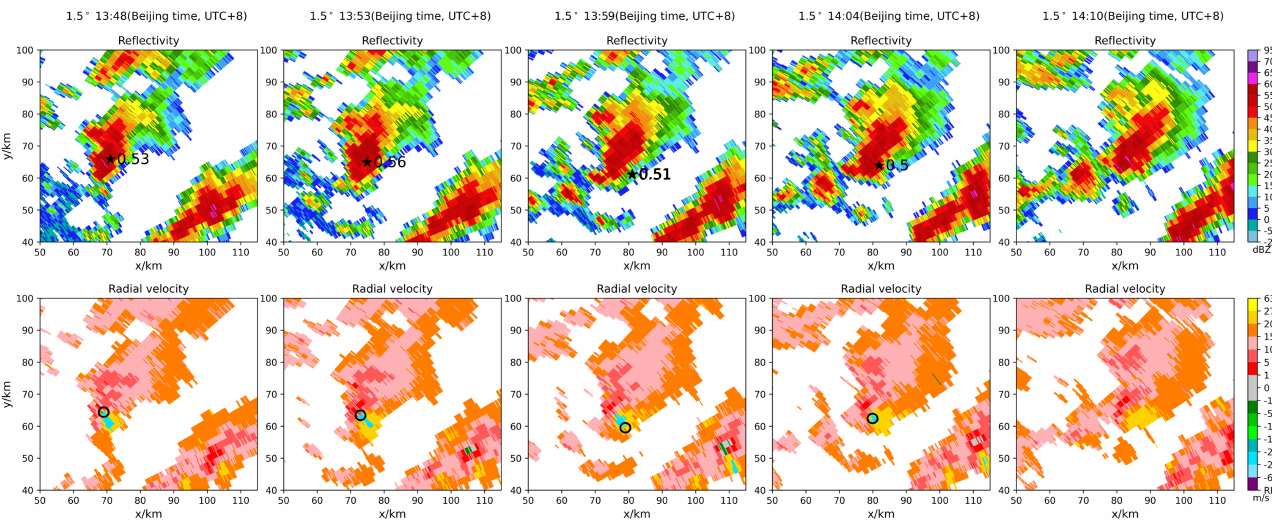
Figure 10. 1.5 ◦ tornado detection results (TDA-RF), Z9250-0612-13:48 to 14:10 (UTC+8), the tornado was EF3. (asterisk corresponds to the identification center, and the value corresponds to the probabil- ity; the black circle has a radius of 1.5 km centered on the identification result; no asterisk and circle indicate that the TDA-RF did not recognize the